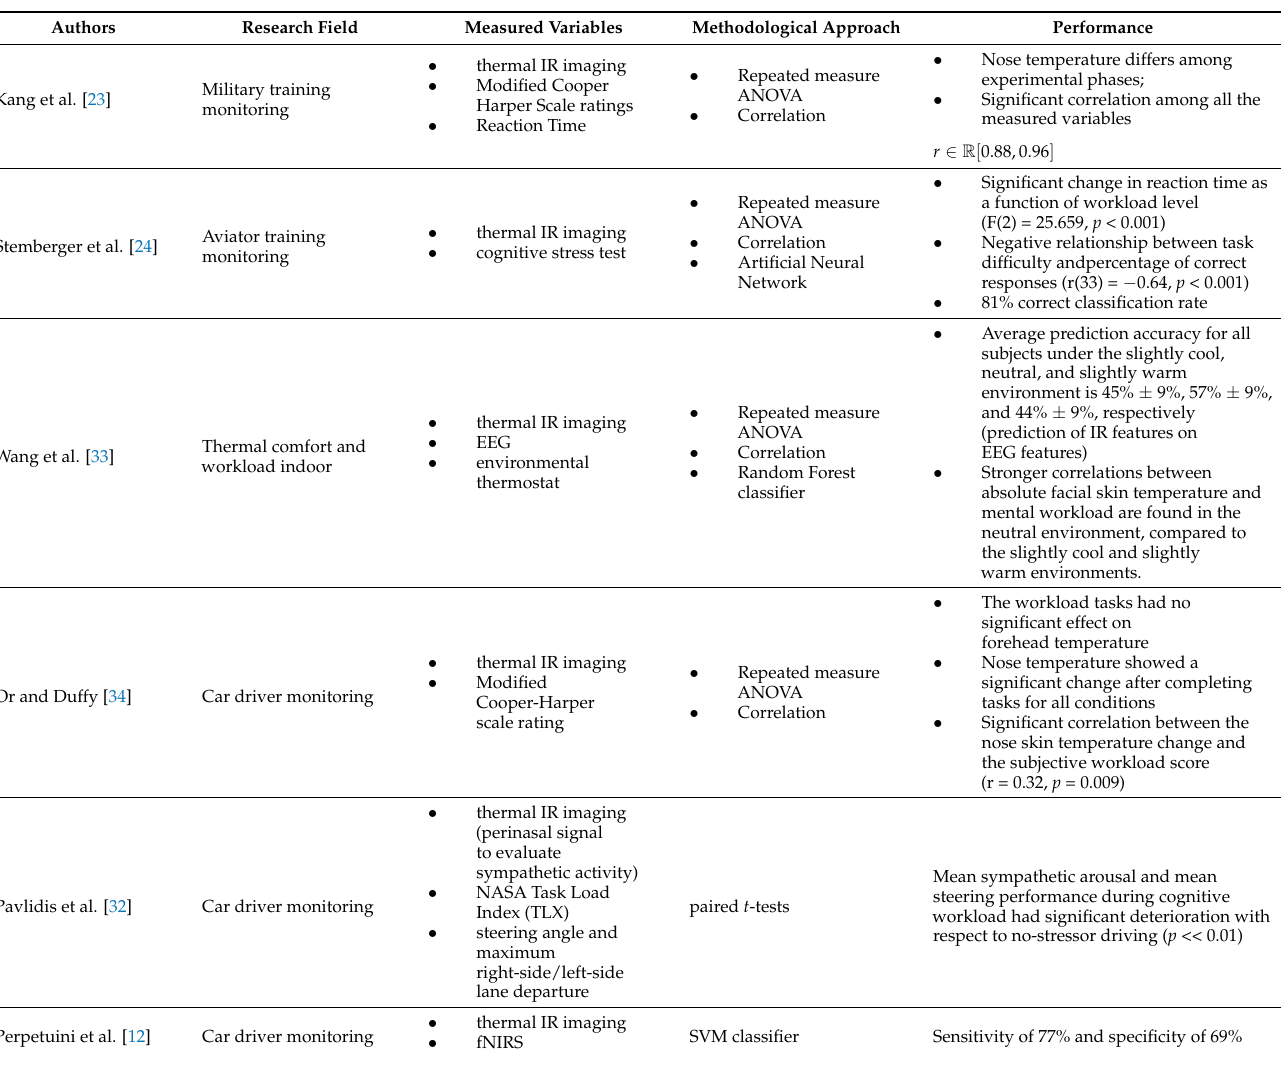
Table 1. Summary of the most related work with research field, measured variables, methodological approach and performances